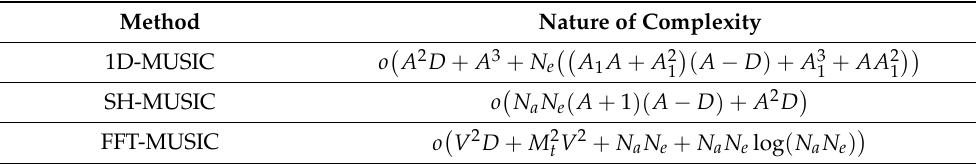
Table 2. Complexity in